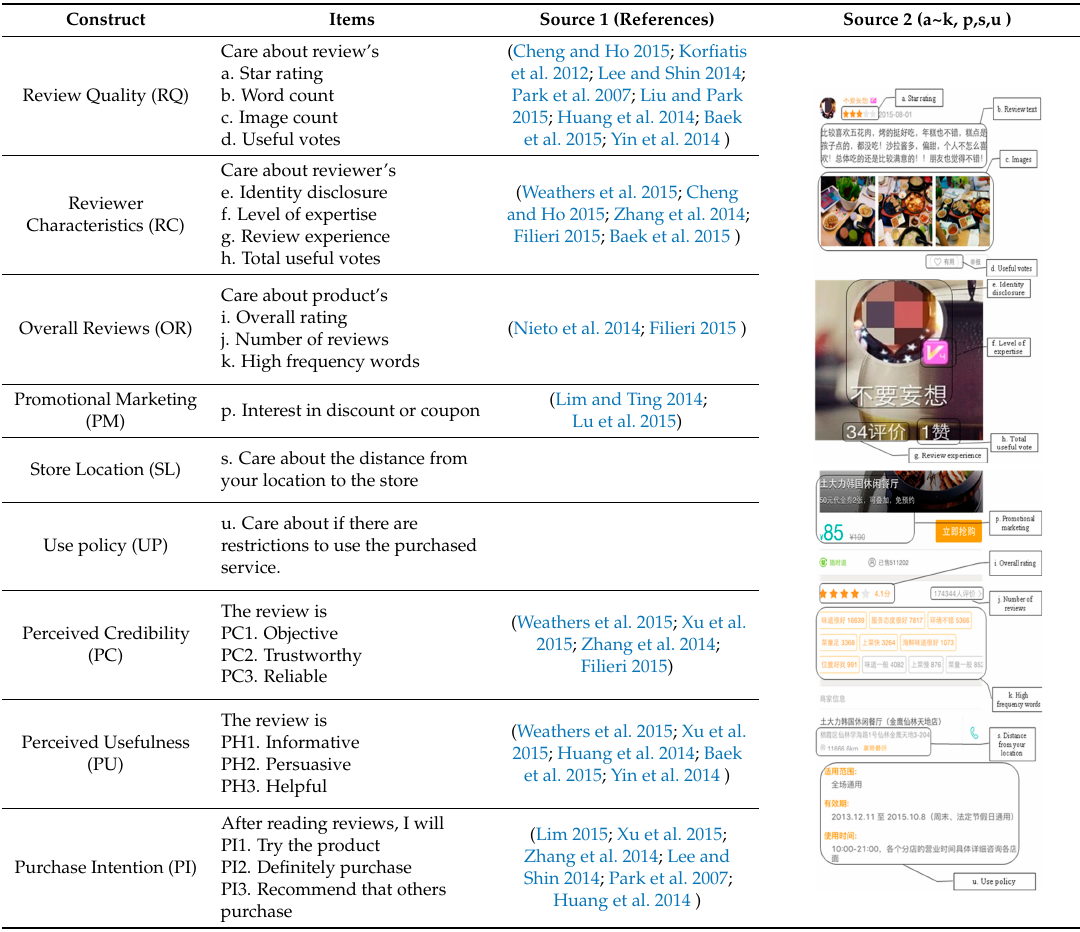
Table A1. Items used in the